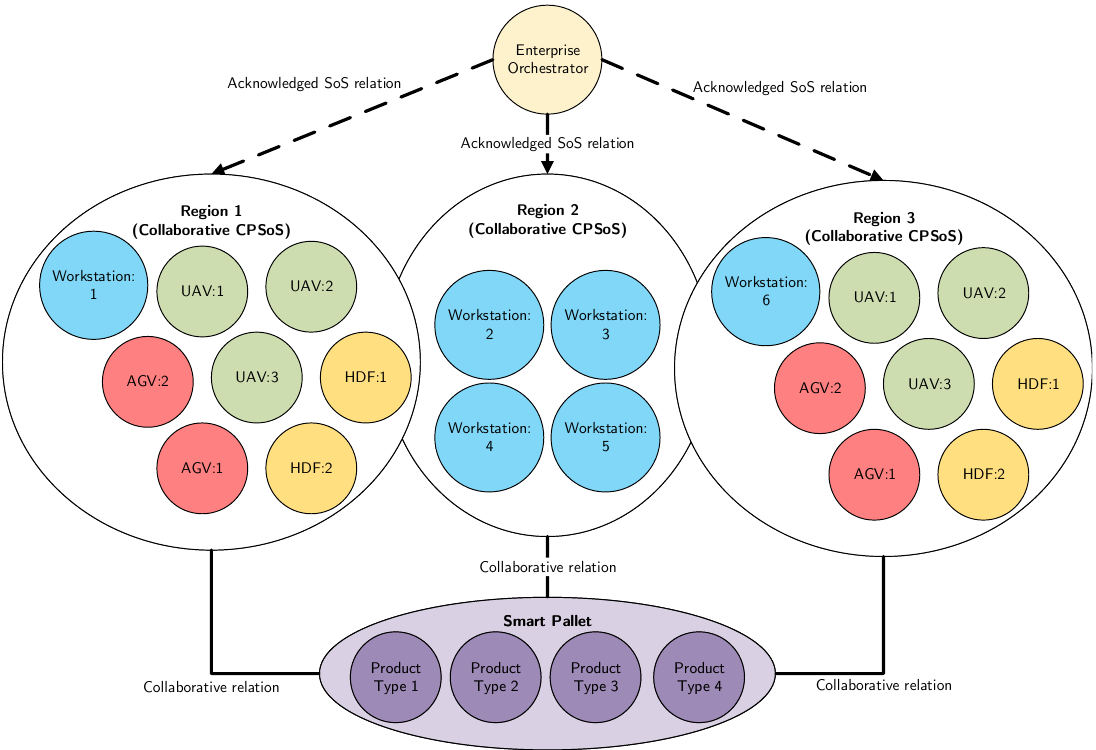
Figure 7. Conceptual framework of the case study’s constituent systems and CPSoS design relations. Each colored part depicts a constituent system. The smart pallet constituent system contains one of the products, which is considered as a nested constituent